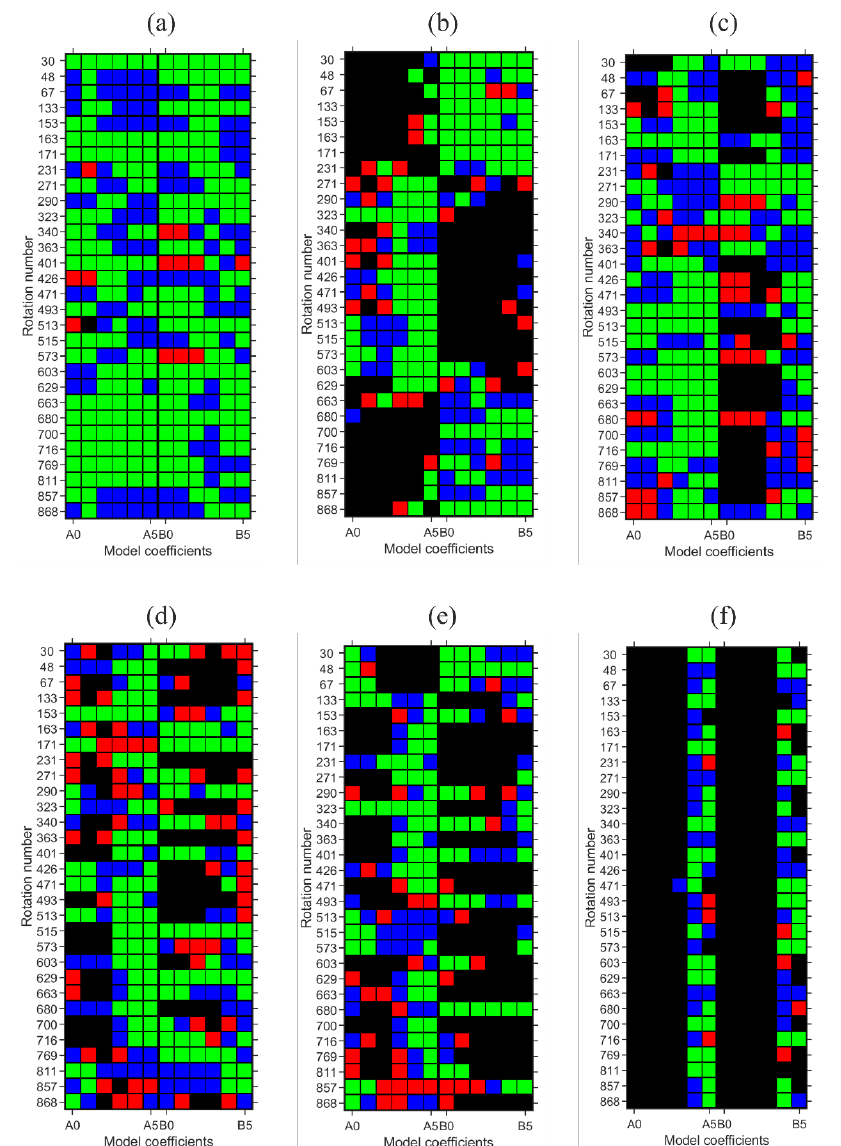
Figure 9. The damage map of bearing (brake side) SKF 1207K: ( a ) undamaged; ( b ) with a damaged outer race; with the cut ball at the depth of: ( c ) 1 mm; ( d ) 2 mm; ( e ) 3 mm; ( f ) with cut inner